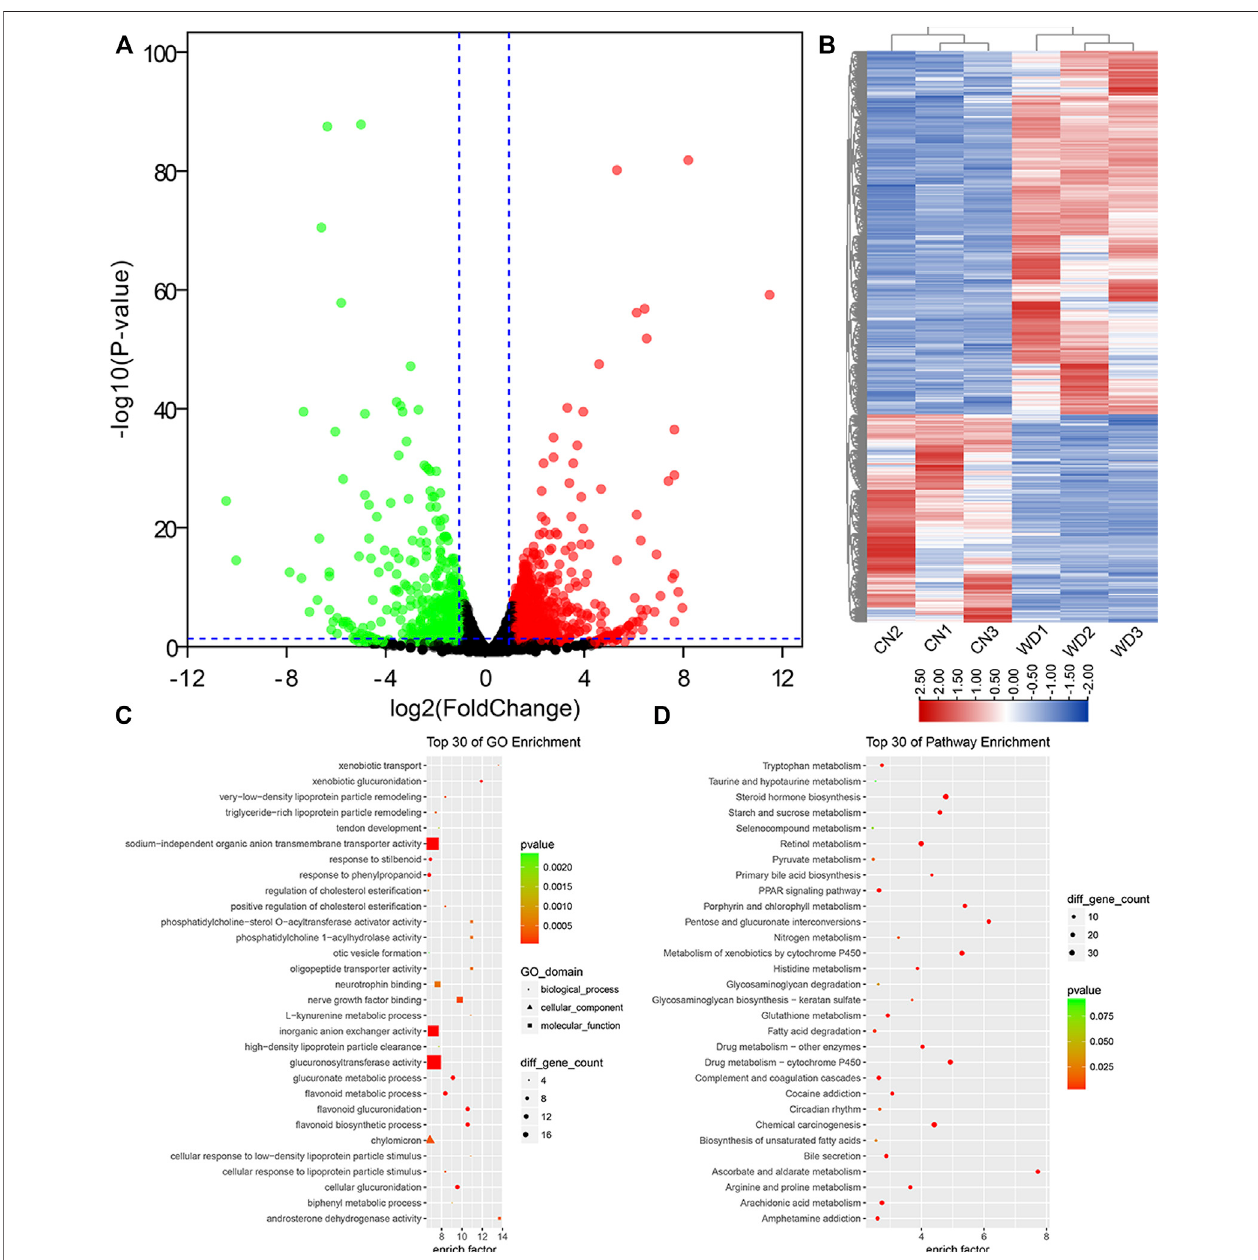
FIGURE 2 | DEPs between the WD and control groups in the kidneys and functional enrichment analysis. (A) DEPs displayed on a volcano plot. Blue and red indicate > two folds decrease or increase in expression, respectively ( p < 0.05). Gray indicates no signi fi cant difference. (B) Hierarchical clustering; numbers indicate the samples used for RNA-seq. (C) Top 30 GO enrichment terms of DEPs. (D) Top 30 KEGG pathway enrichment terms of DEPs. DEPs, differentially expressed protein- coding